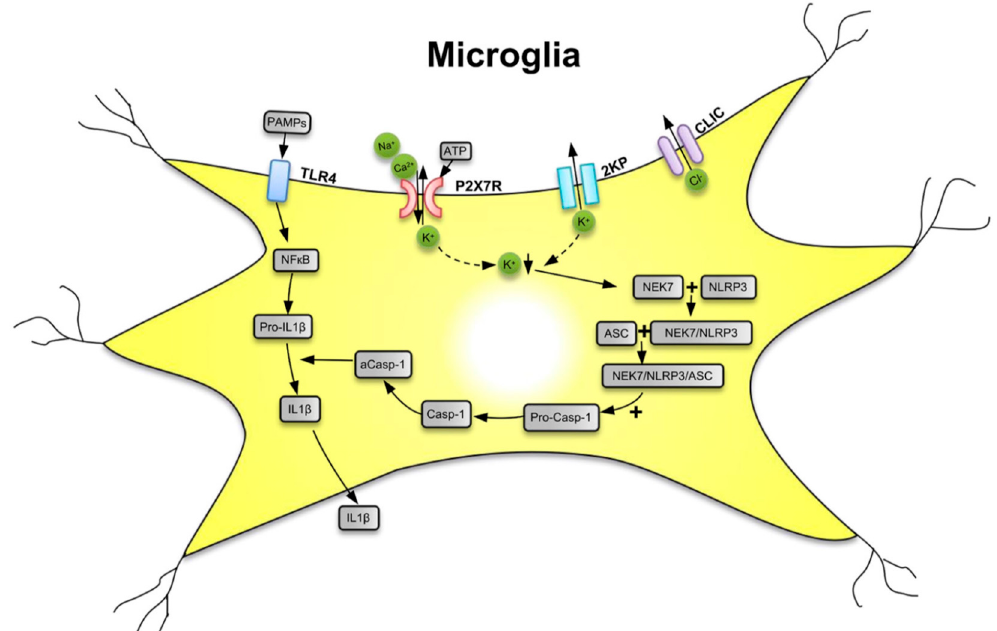
Figure 1. Secretion of interleukin-1 β (IL-1 β ) from microglial cells via involvement of the nucleotide-binding, leucine-rich repeat, pyrin domain containing 3 (NLRP3) inflammasome. Pathogen-associated molecular patterns (PAMPs; e.g., bacterial lipopolysaccharide (LPS)) act on toll-like receptor-4 (TLR4) and cause its phosphorylation. In consequence, in the cell nucleus, NF- κ B is activated, which promotes the synthesis of the NLRP3 inflammasome and pro-IL-1 β , both accumulating in the cytosol in their inactive forms. The activation of NLRP3 is primarily due to a decrease of the intracellular K + concentration [K + ] i , initiated by the stimulation of P2X7Rs by high local concentrations of the molecule ATP, which is considered to be a danger-associated molecular pattern (DAMP). P2X7Rs allow the inward flux of Na + /Ca 2+ and in exchange the outward flux of K + , leading to a fall in [K + ] i . The opening of two-pore domain potassium channels (2KP) may also lead to an impoverishment of cytoplasmic K + . A further stimulus for NLRP3 activation is the outward flux of Cl − through chloride intracellular channels (CLICs). TLR4, P2X7Rs, 2 KP channels, and CLICs are all located in the cell membrane of microglia. A sensor for the fall in [K + ] i is the NEC7 serine/threonine kinase. NEC7 is able to form a complex with NLRP3, which is still inactive, but after constitution of a still larger multimeric complex with apoptosis-associated speck-like protein (ASC) binds also pro-caspase-1 (pro-Casp-1). In consequence, pro-Casp-1 is cleaved to Casp-1, which then by its activated form aCasp-1 degrades pro-IL-1 β to mature IL-1 β . Then, IL-1 β leaves the cell by a number of mechanisms to the extracellular space and exerts its effects as a neuroinflammatory cytokine. K + with downward arrow, decrease of the K + concentration. Reproduced with permission from [37].